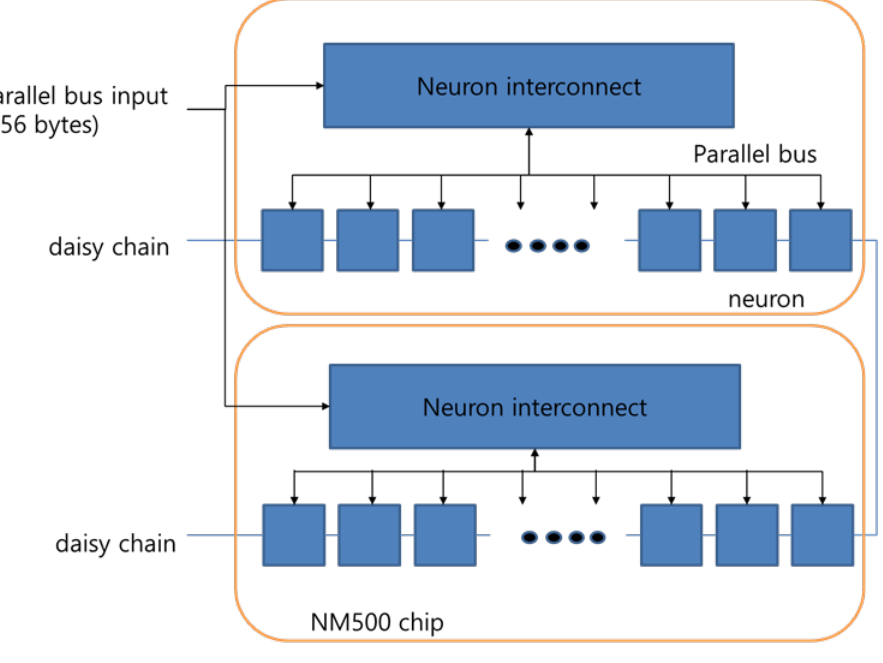
Figure 1. The interconnection architecture of the NM500.